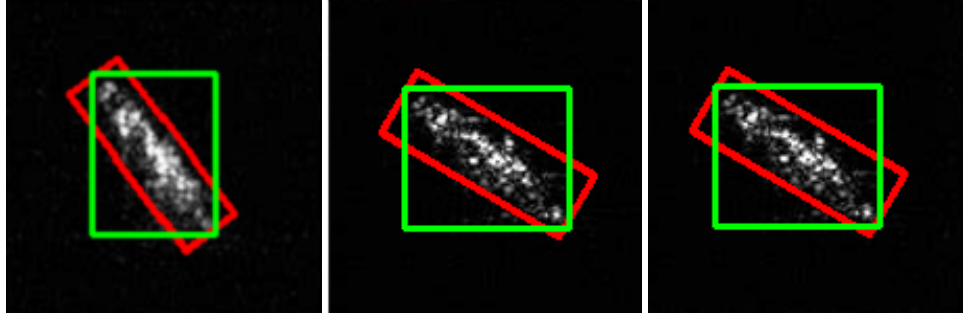
Figure 9. Bounding boxes: green rectangles represent the bounding box generated by YOLO; the red one represents the area marked by classical image-processing